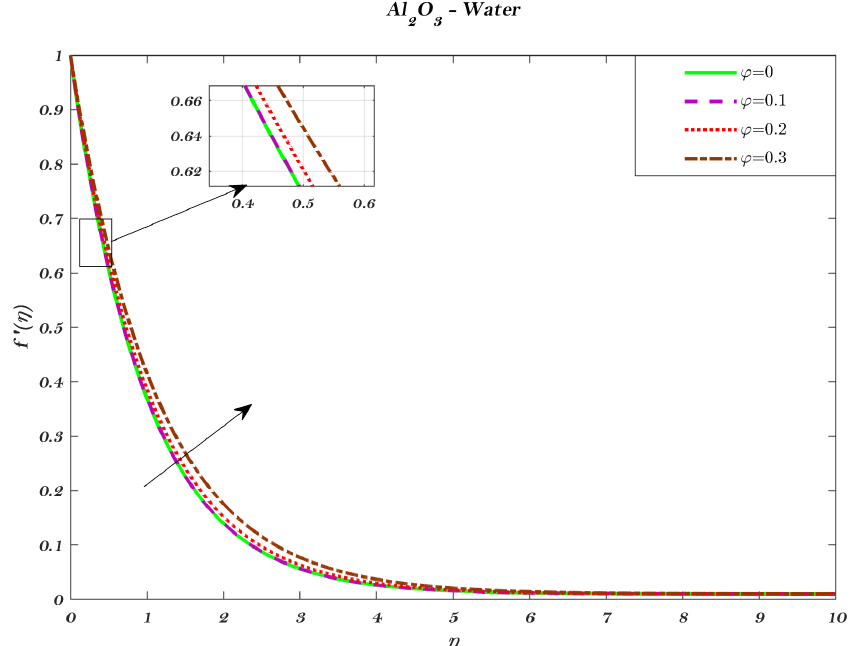
Figure 2. Velocity profile as a function of nanoparticle volume fraction ϕ with fix parameters (cid:101) = 0.02 ˘ a = 0.01 and P r = 6.96.